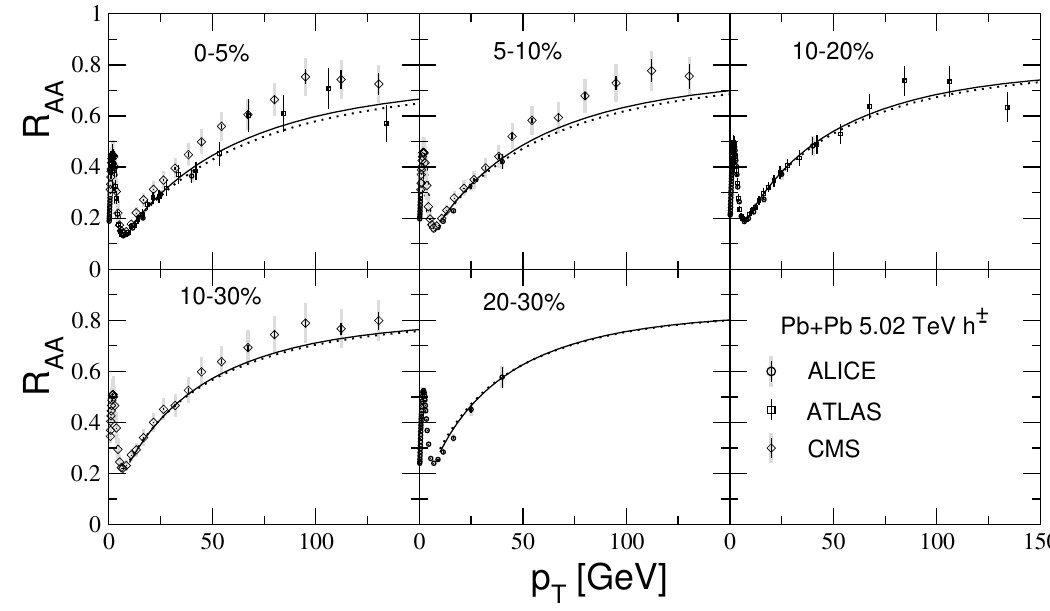
√ Figure 5 . Same as in figure 4 for s = 5 . 02 TeV for the optimal parameters κ = 3 . 47 and 2 . 5 . Data points are from ALICE [78], ATLAS [79], and CMS